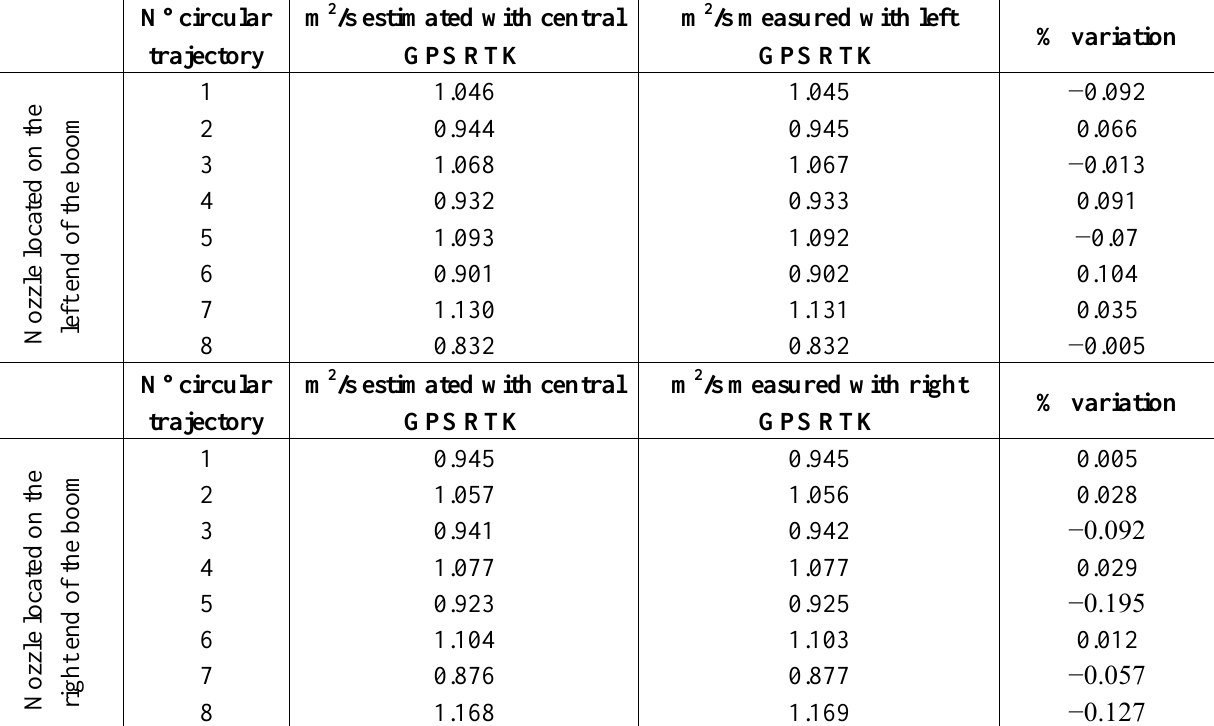
Table 1. Surface area treated per unit time by the nozzles on either end of the boom calculated from the information provided by the GPS RTK located at the center of the boom and by the GPS RTK located on the right and left